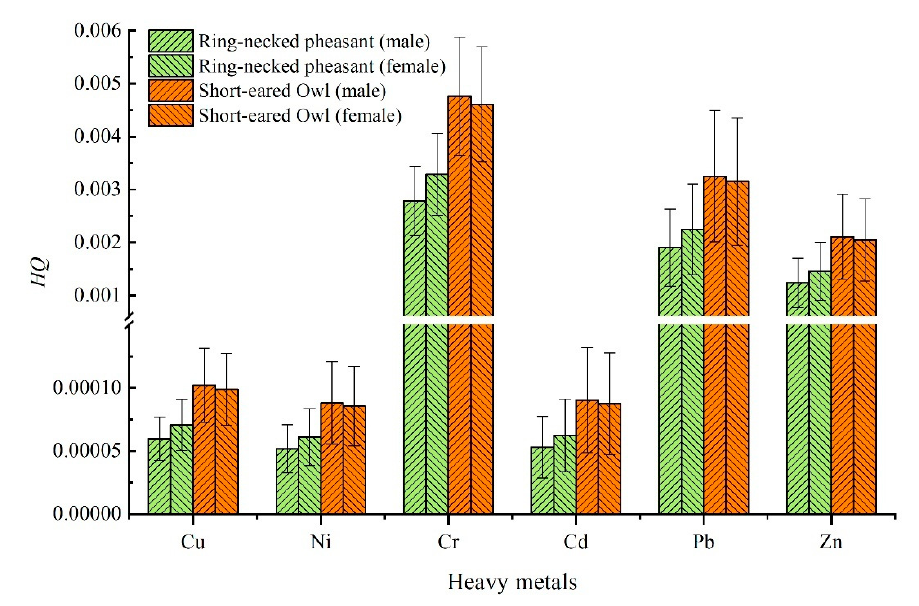
Figure 6. Average hazard quotient for ring-necked pheasant and short-eared owl.